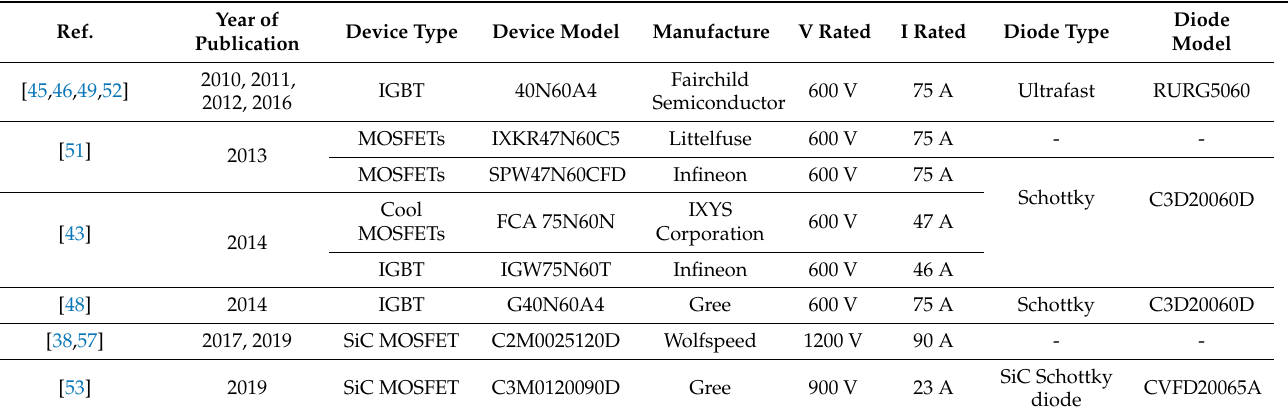
Table 2. Semiconductor components of transformer and transformerless bidirectional topologies for DC distribution systems.